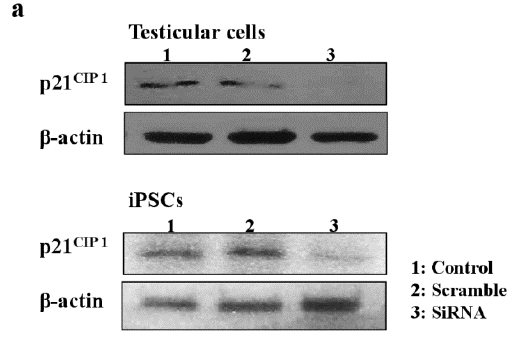
Figure 5. Effects of the knockdown of p21 CIP1 expression by siRNA on gene expression and apoptosis. Bovine iPSCs were treated with p21 CIP1 siRNA, or a scrambled nonspecific siRNA, and treated with DMSO or 10 − 4 M MEHP for 12 h. ( a ) The expression levels of p21 CIP1 were measured by Western blotting as described in the Experimental section. Lane 1; non-treated siRNA; lane 2, scramble siRNA; lane 3, p21 CIP1 specific siRNA; ( b ) The expression levels of p21 CIP1 were measured in triplicate samples by qRT-PCR, and were corrected to the GAPDH RNA levels; ( c ) Apoptotic cells were quantified by staining with annexin V, as described in the Experimental Section. (–, control DMSO (0.001%); +, 10 − 4 M MEHP in the presence (+) or absence (–) of the p21 CIP1 siRNA or scrambled siRNA). The values expressed as means ± SEM, n ˃ 3; ** p <